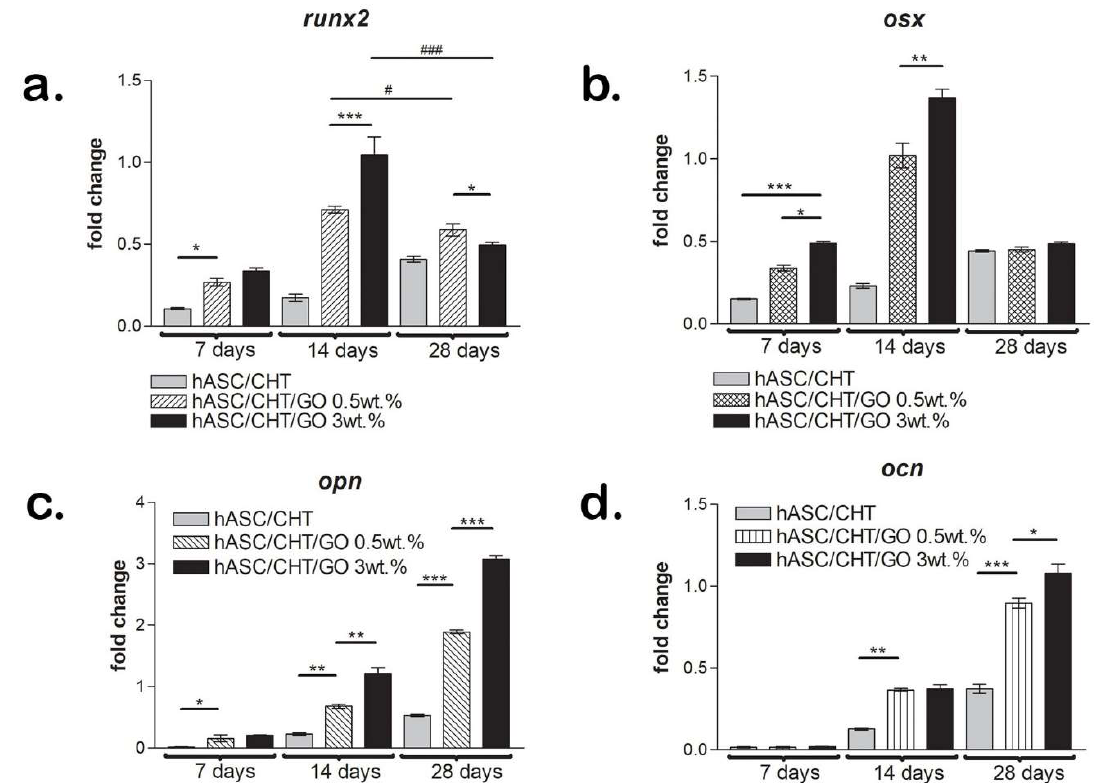
Figure 6. Gene expression of osteogenic specific markers— runx2 , osx , opn, and ocn . ( a – d ) runx2 , osx , opn , and ocn profiles of gene expression obtained by qPCR in BC, BC0.5, and BC3 after 7, 14, and 28 days of differentiation of hASCs in pro-osteogenic conditions. */# p < 0.05; ** p < 0.01; ***/### p < 0.001. Fold change in qPCR data analysis was determined by 2 −ΔΔCt method.